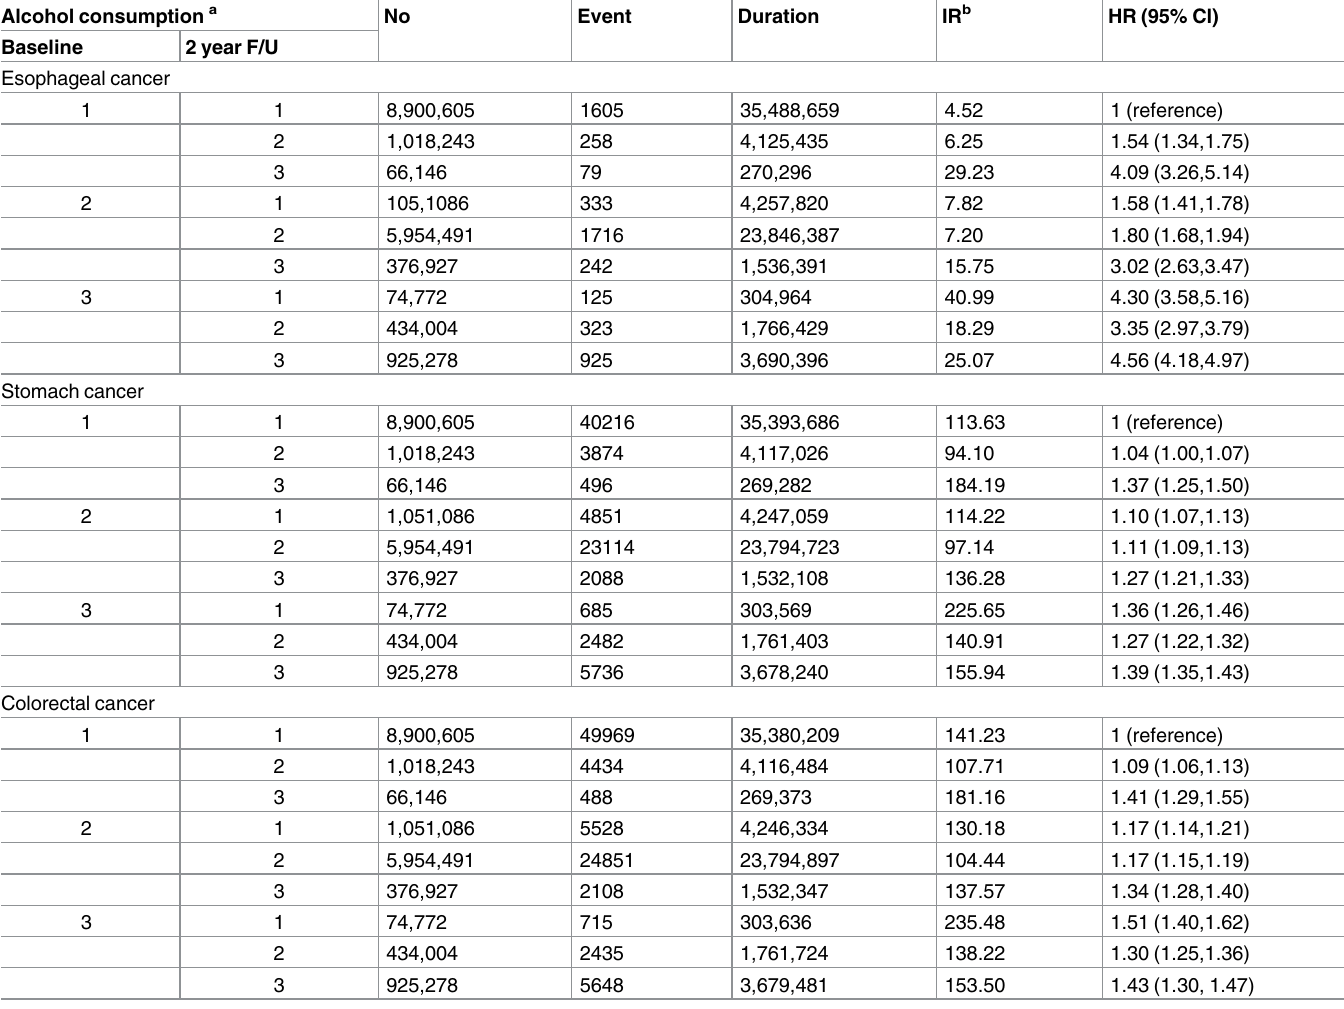
Table 4. The effect of change in the amount of alcohol consumption and the risk of developing esophageal, stomach and colorectal